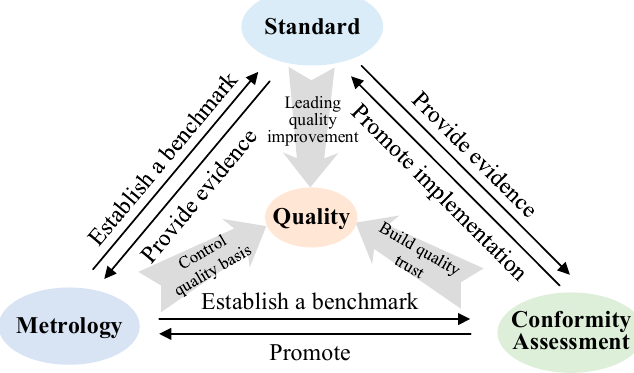
Figure 2. The relationship between the three elements of NQI.